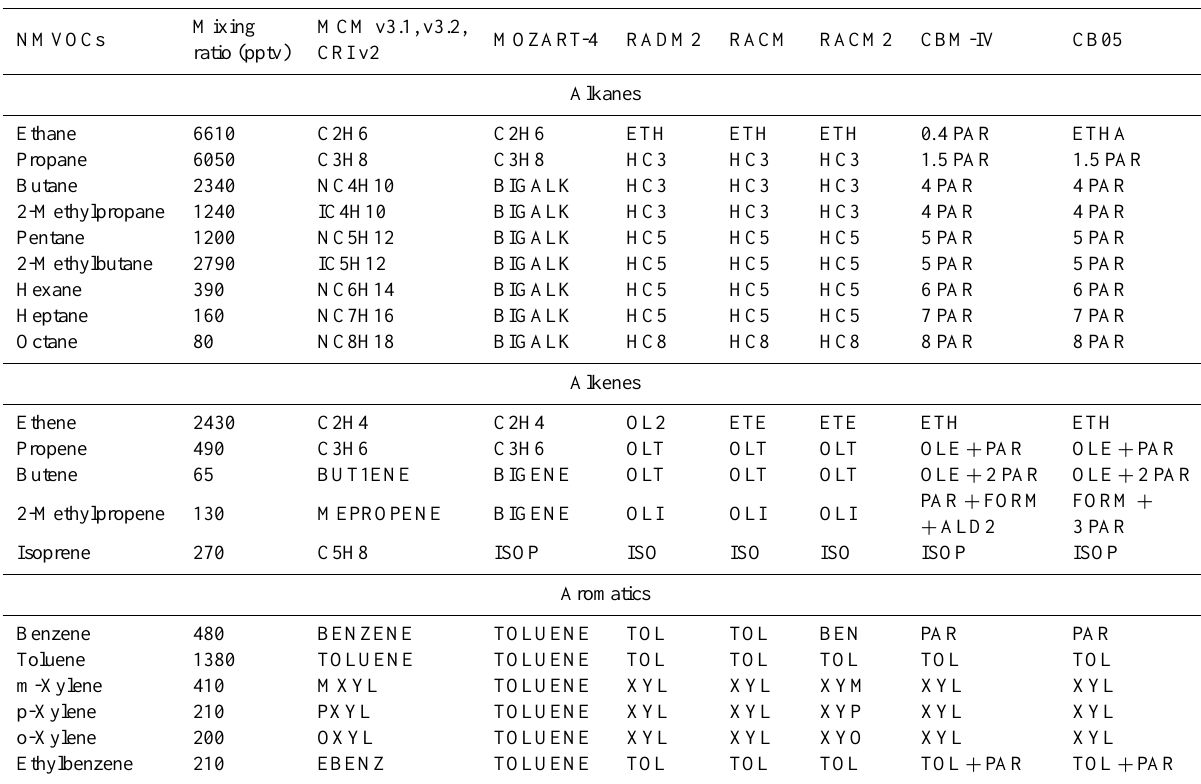
Table 2. Non-methane volatile organic compounds (NMVOCs) present in Los Angeles. Mixing ratios are taken from Baker et al. (2008) and their representation in each chemical mechanism. The representation of the VOCs in each mechanism is based upon the recommendations of the literature for each mechanism (Table